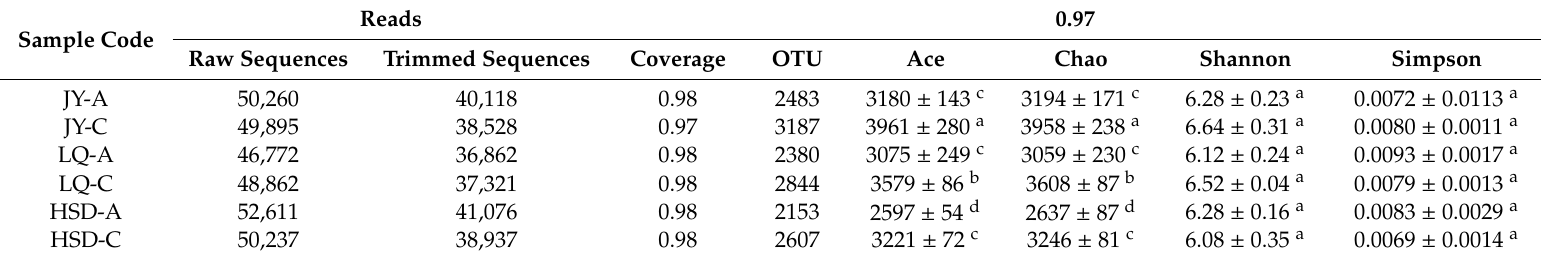
Table 2. Characteristics of soil bacterial richness and diversity indices in di ff erent soil